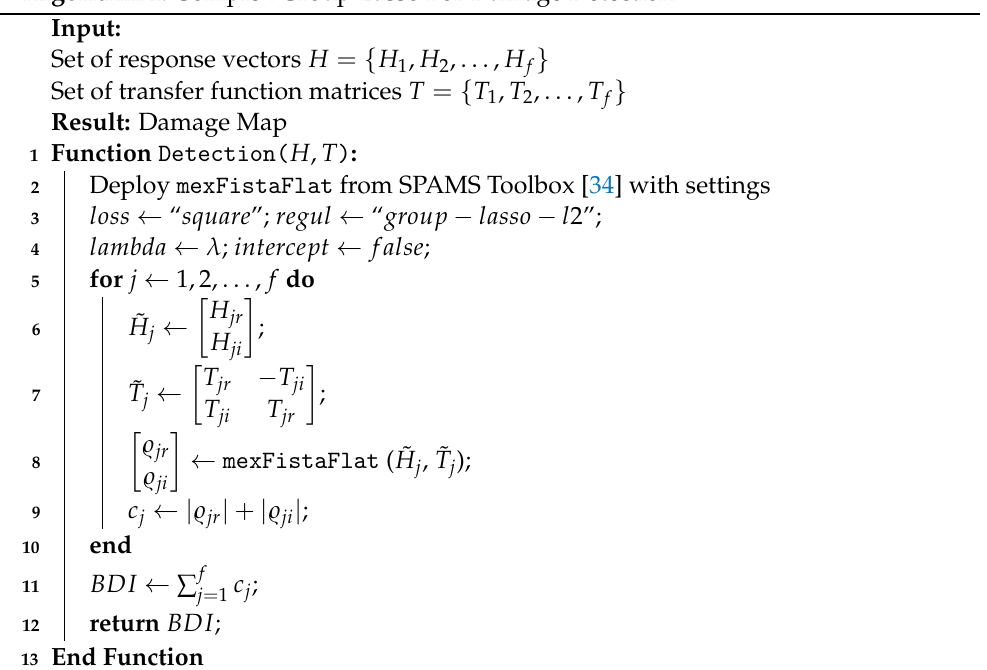
Algorithm 1: Complex Group Lasso For Damage